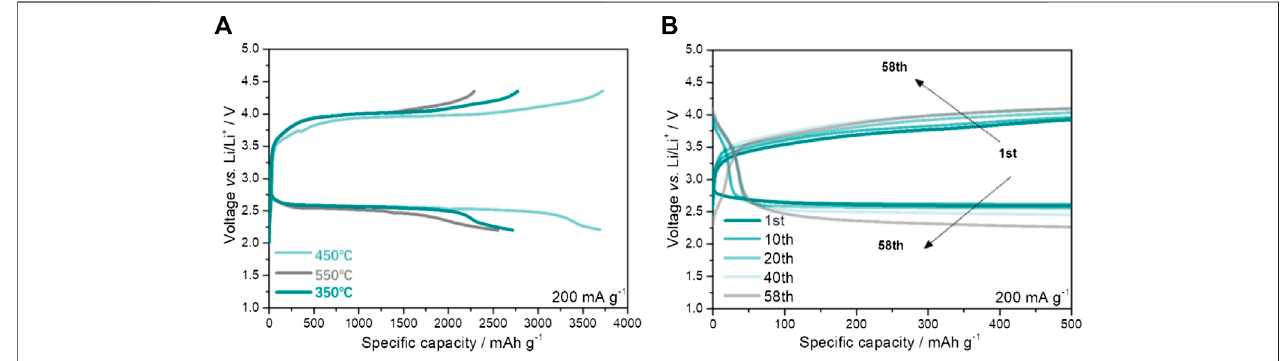
FIGURE5|(A) Galvanostaticdischarge/chargepro fi lesofDMO@GFelectrodesand (B) thecyclingperformanceof450-DMO@GFcathode.Thecurrentdensityis 200 mA g − 1 .